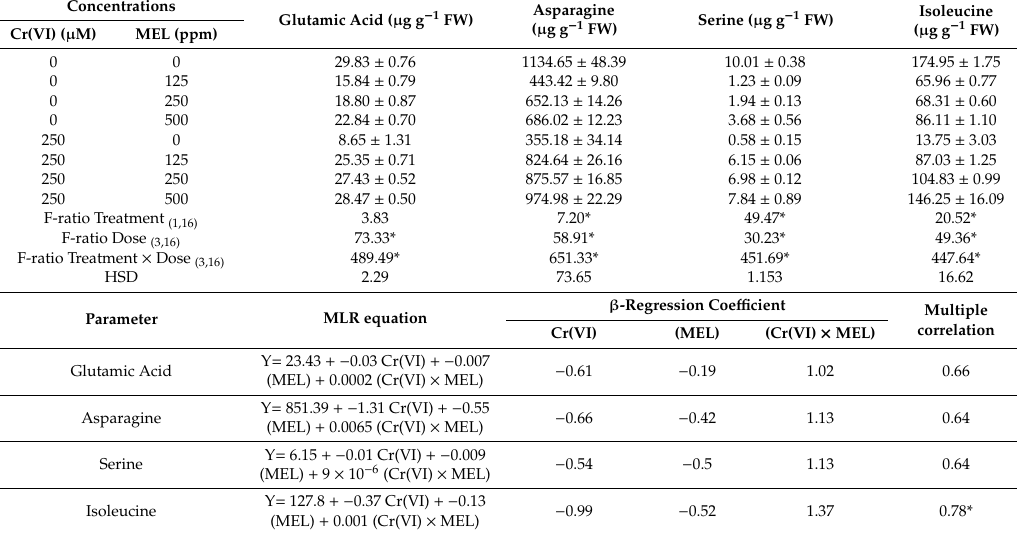
Table 9. Effect of Cr(VI), different concentrations of methanol extract of Rhododendron arboreum leaves (MEL), and their combinations on glutamic acid, asparagine, serine, and isoleucine contents in 7-day-old Vigna radiata seedlings. The values are the means of three replicates ± S.D. (standard deviation). Tukeys test performed and significance checked at * p ≤ 0.05. The F ratio is the term in which ANOVA is represented; Cr(VI) = Dose, MEL treatments = Treatment and combination of Cr(VI) and MEL = Dose × treatment.